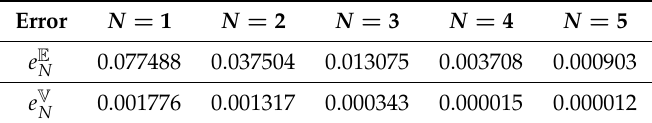
Figure 4. Left: Comparison of the exact mean and the mean different approximations of the solution SP to the random IVP (27) taking as orders of truncation for the approximate series the values N ∈ { 1,2,3,4,5 } . Right: Comparison of exact variance and the variance different approximations of the solution SP to the random IVP (27) using the same orders of truncation. Example 1. V Table 2. Values of errors for the mean, e E , and the variance e , given by (33) for N ∈ { 1,2,3,4,5 } . Example N N